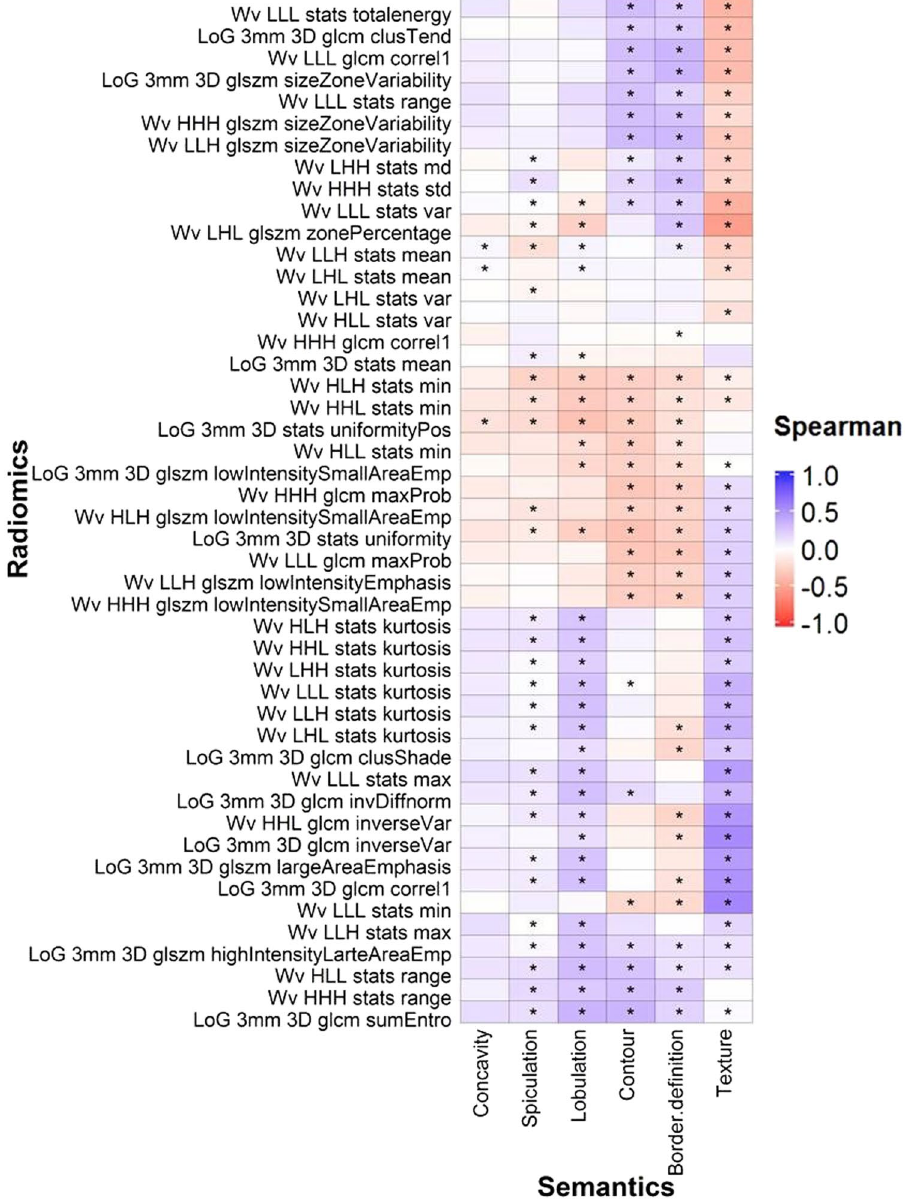
Figure 5. Associations between the categorical semantic and unfiltered radiomic features assessed with Spearman coefficient correlation. * Indicates a statistically significant association (q-value ≤ 0.05). Wv = Wavelet. LoG = Laplacian of